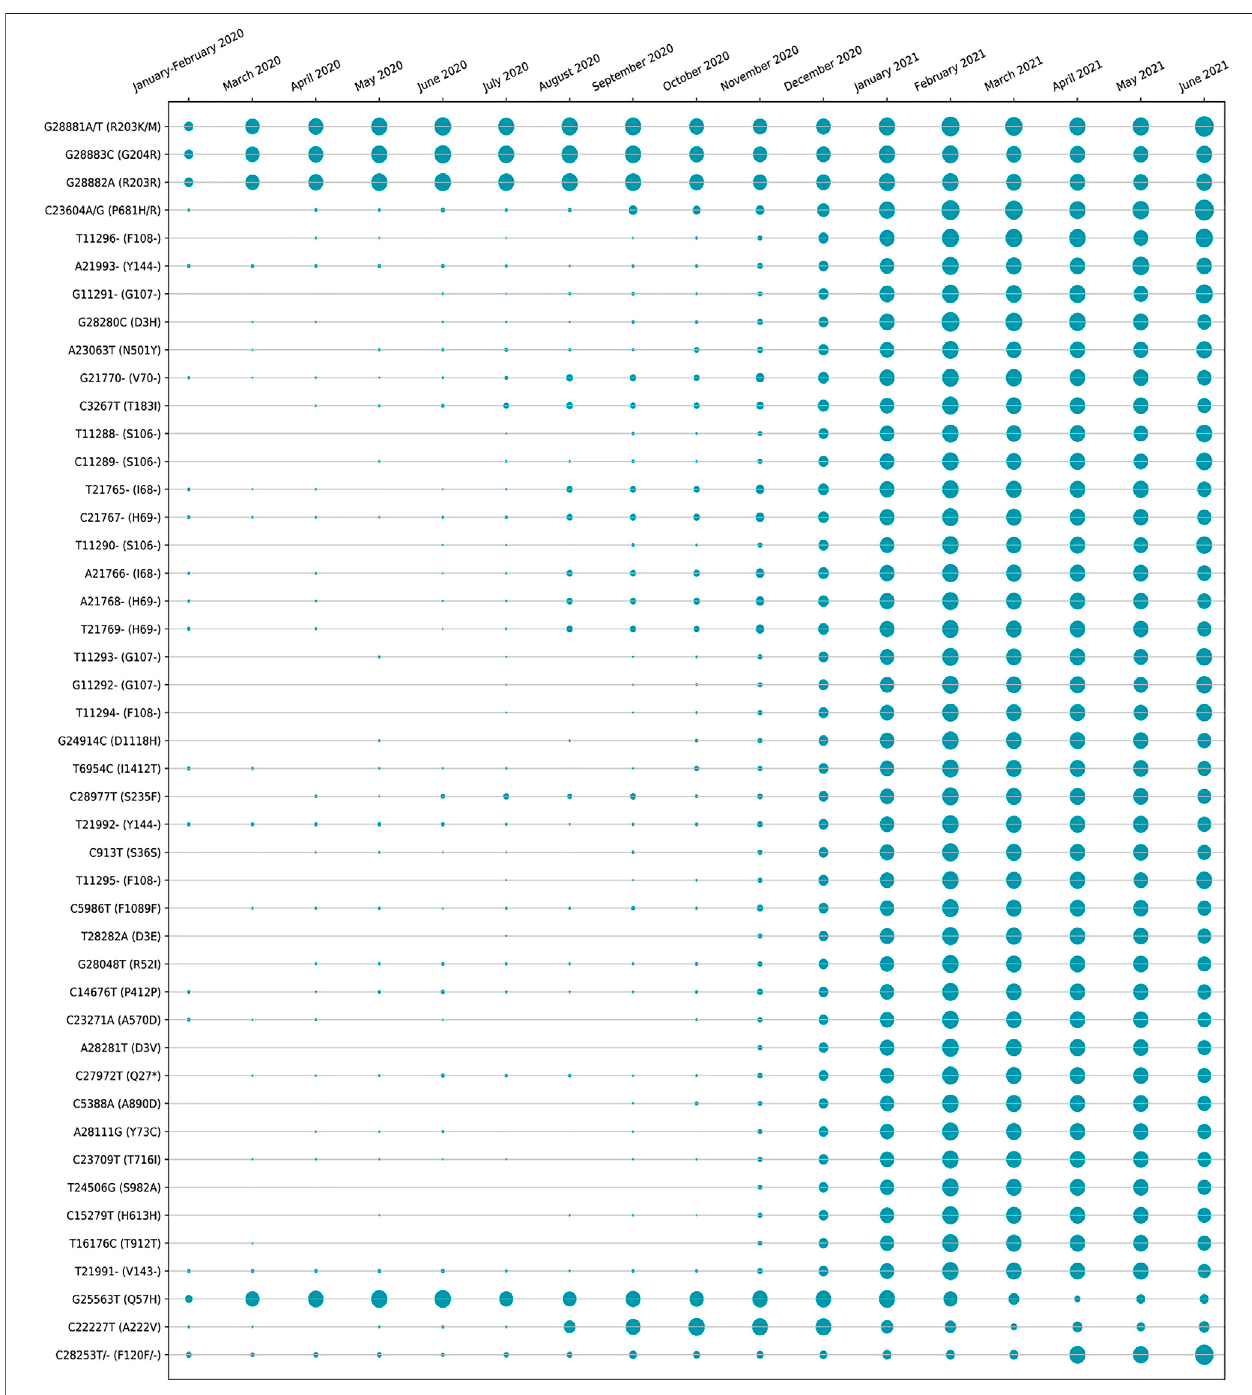
FIGURE 5 | Month-wise evolution of global SARS-CoV-2 genomes based on entropy.